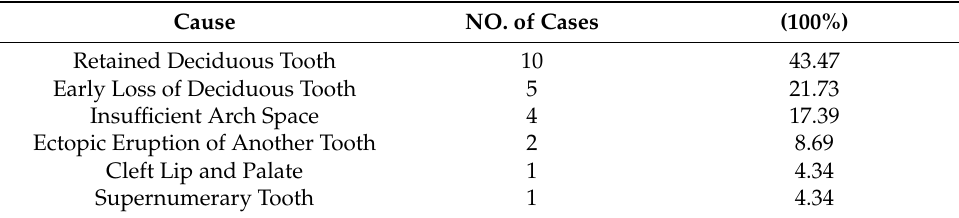
Table 3. Frequency distribution of delayed eruption cases according to